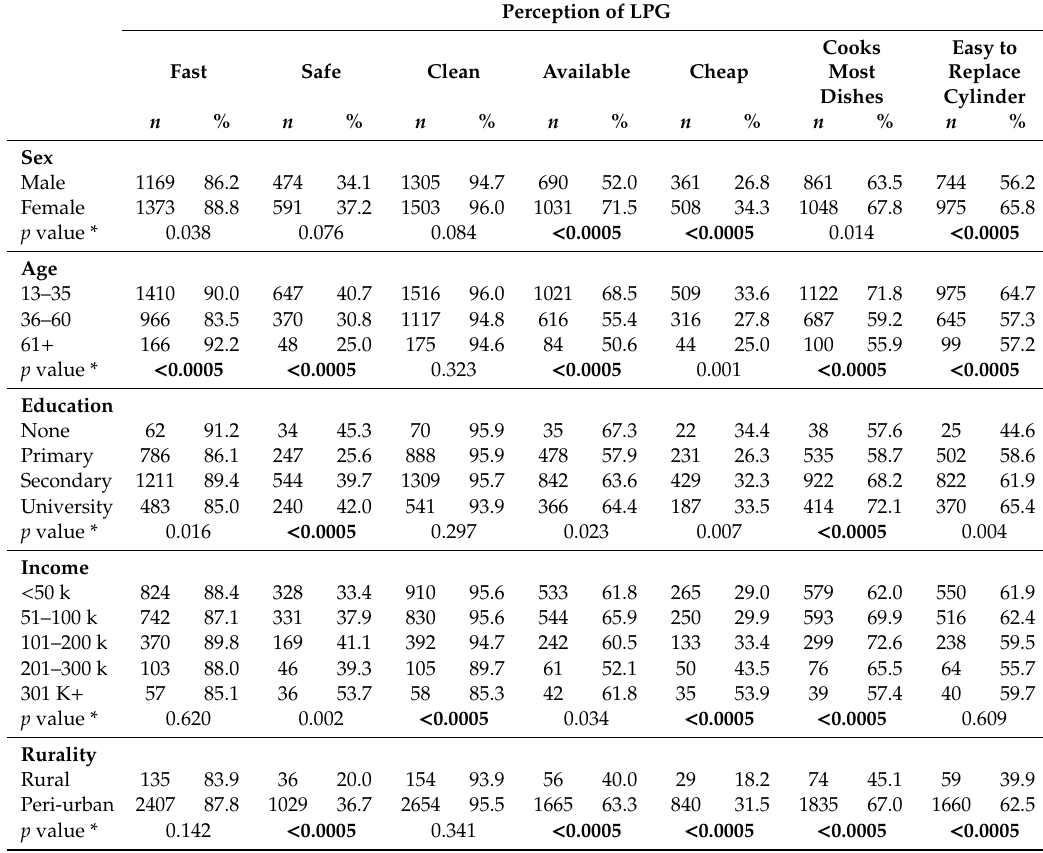
Table 6. Likelihood of viewing LPG positively in seven categories, according to the main socio- demographic